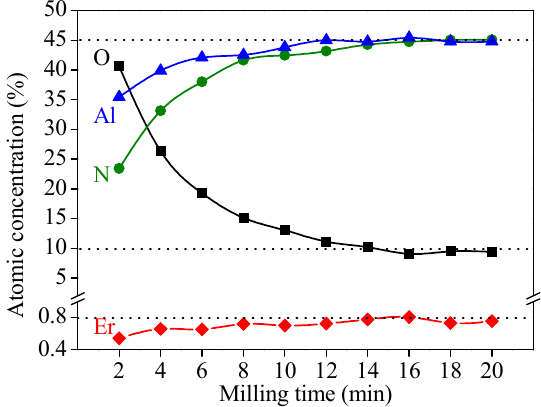
Figure 4. The variation of atomic concentrations with milling time.